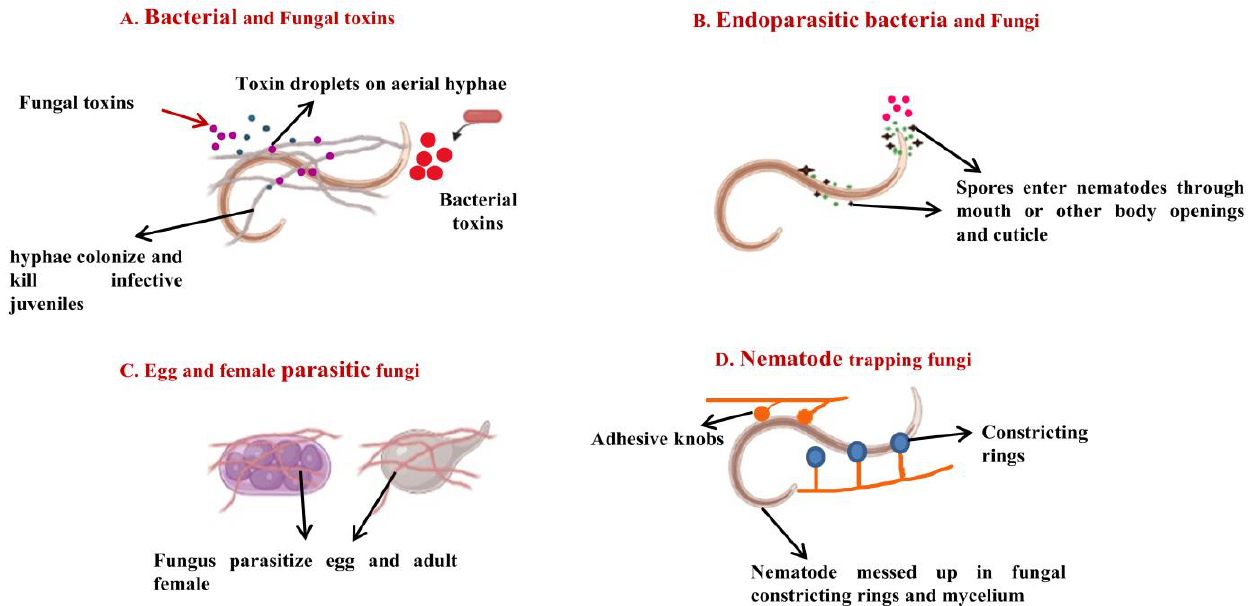
Figure 2. Mechanisms of bacterial and fungal biocontrol. ( A ). Bacterial and fungal toxins: Bacteria (e.g., Bacillus thuringiensis ) and fungi (e.g., Pleurotus ostreatus ) produce certain toxins that suppress plant-parasitic nematodes by preventing their hatching and may even cause death to juveniles [58]. ( B ). Endoparasitic bacteria and fungi: They produce motile spores that enter nematodes through the mouth or other body openings and cuticle and may be lethal to nematodes. ( C ). Egg- and female- parasitic fungi: Certain fungi such as Pochonia chlamydosporia parasitize the eggs and adult females of plant-parasitic nematodes [58]. They form branched mycelia around eggs and adult females and suppress plant-parasitic nematodes. ( D ). Nematode-trapping fungi: These fungi trap nematodes with the help of constricting rings or adhesive knobs and kill them, e.g., Arthrobotrys dactyloides.